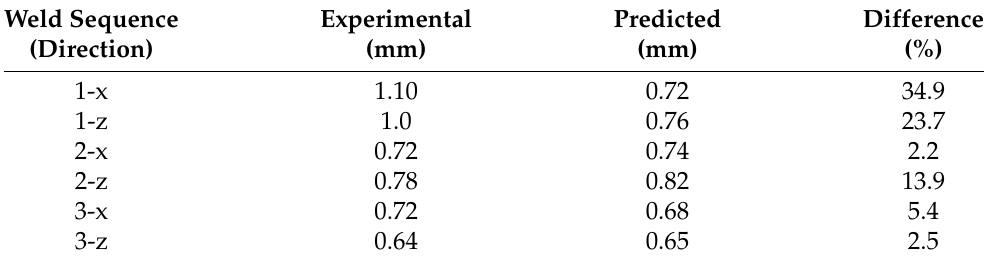
Table 2. Vetriselvan’s analysis.